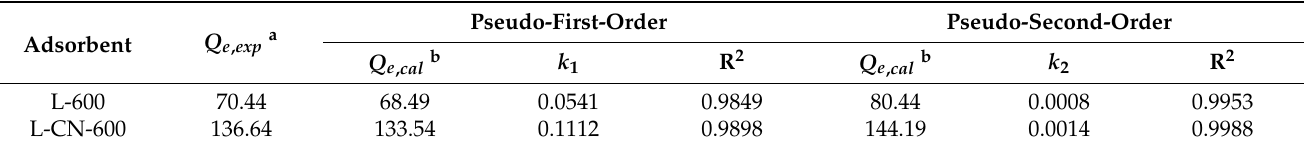
Table 5. The kinetic parameters of phenol adsorption over L-600 and L-CN-600 samples. Adsorbent